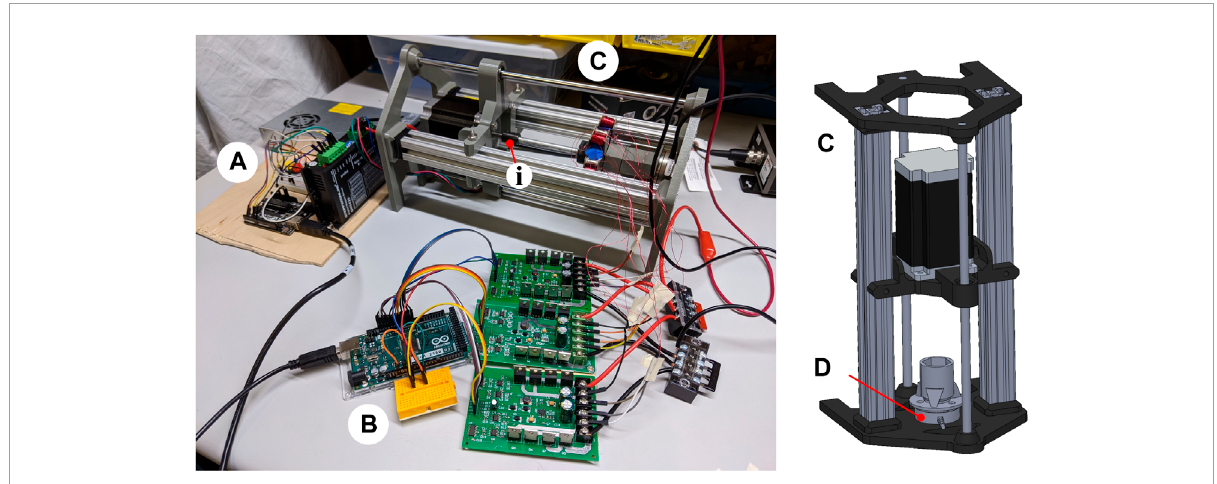
FIGURE 8 The full test-bed for measuring the torque transmission of the MEC, consisting of (A) an Arduino Uno with power supply and stepper driver to control a stepper motor for the input torque to the MEC, (B) an Arduino Mega to control three H-bridge Motor Driver connected to a bench-top power supply for current supply to the MEC (not shown), and (C) the mounting frame allowing the stepper motor to slide linearly into place and be coupled to the MEC input shaft (see Figure 7A ) with a set screw collar (i), and (D) the force-torque sensor on the bottom, with a collar for holding the bottom component of the MEC.